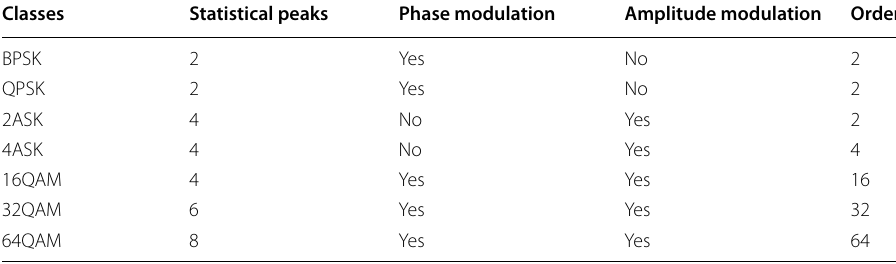
Table 3 The semantic description of each category Classes Statistical peaks